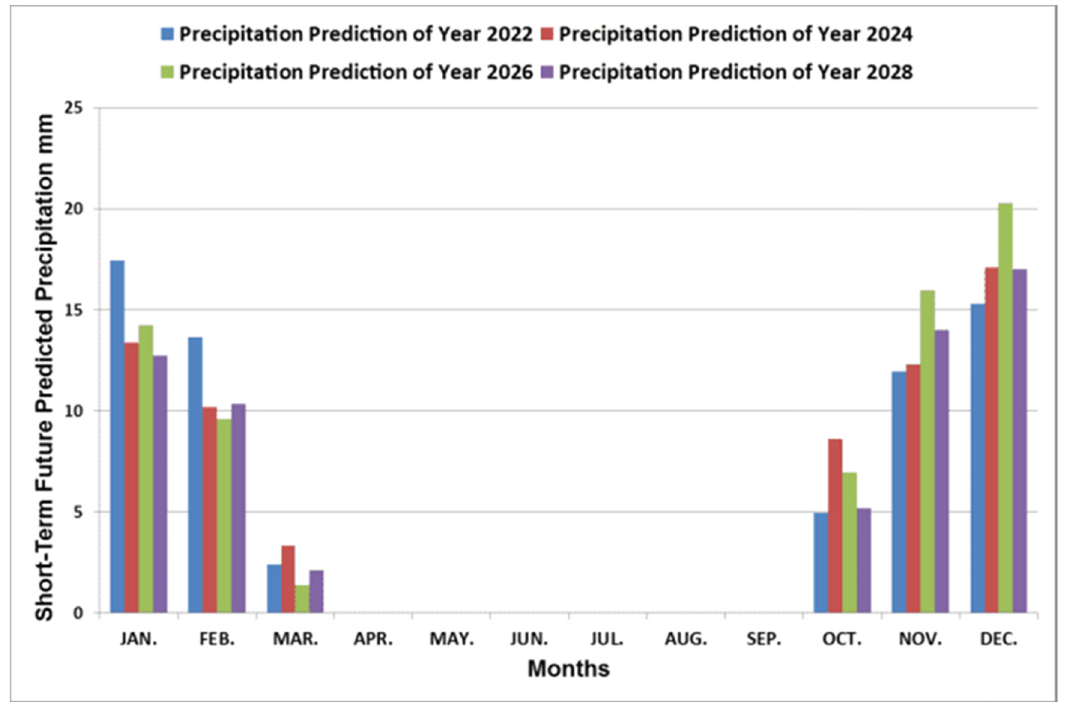
Figure 7: Predicted precipitation at the short - term stage for the years 2022, 2024, 2026, and